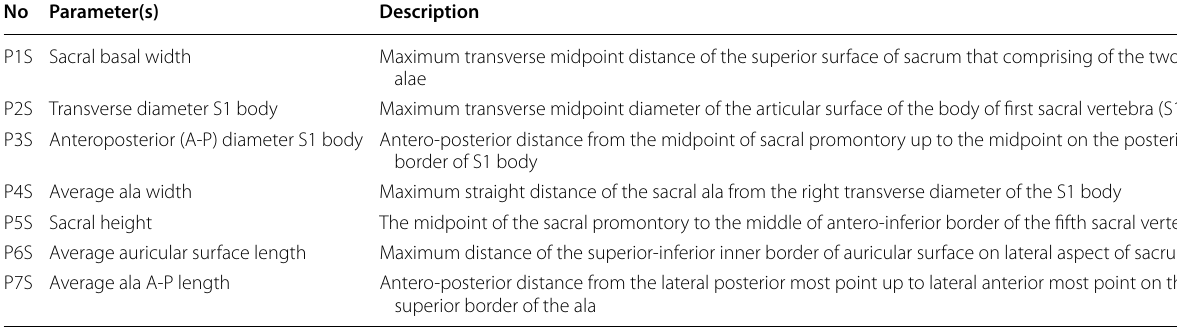
Table 2 Definition and description of sacrum parameters adopted from Kanika et al. (2011) and Shreekrishna et al. (2013) No